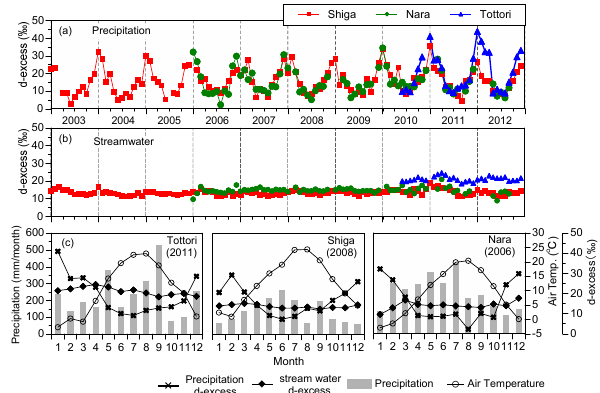
Figure 6. Seasonal variations of d-excess values in precipitation and stream water. (a) Long-term variation of monthly d-excess in pre- cipitation. (b) Long-term variation of monthly d-excess in precipita- tion. (c) Typical examples of monthly d-excess values with monthly precipitation and air